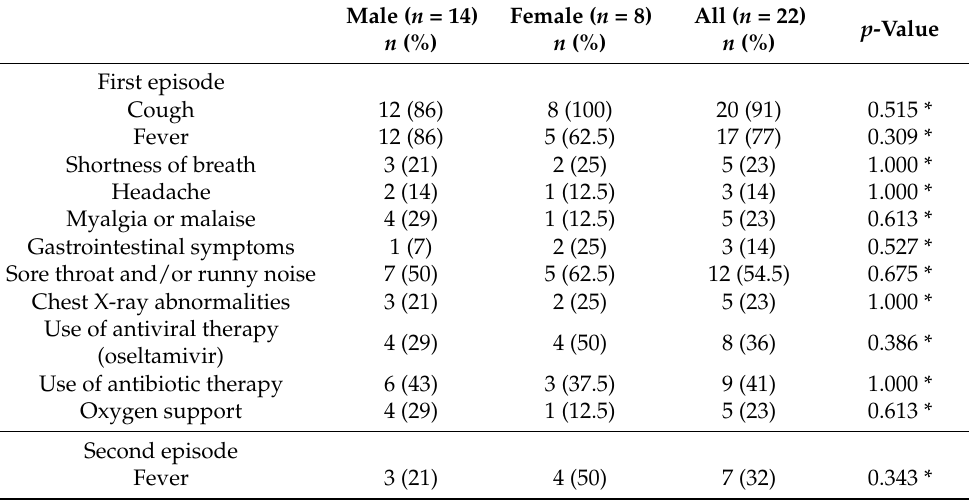
Table 3. Symptoms, presence of chest X-ray abnormalities, and treatment of the participants ( n = 22).